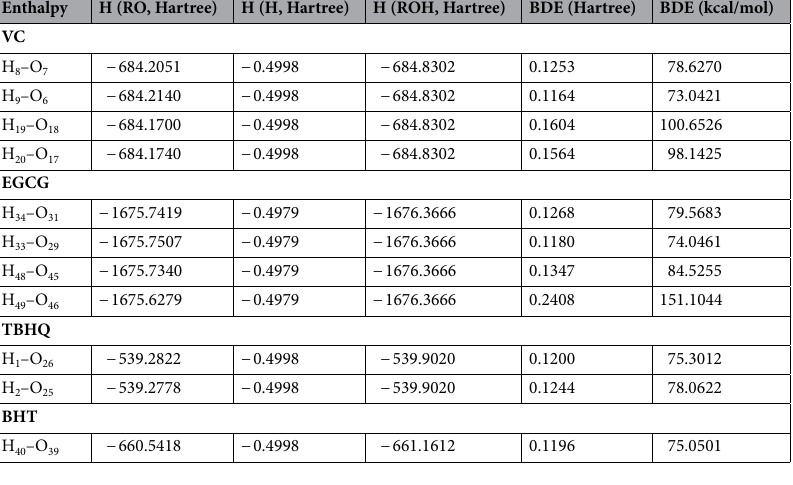
Table 5. H-OBDE of model